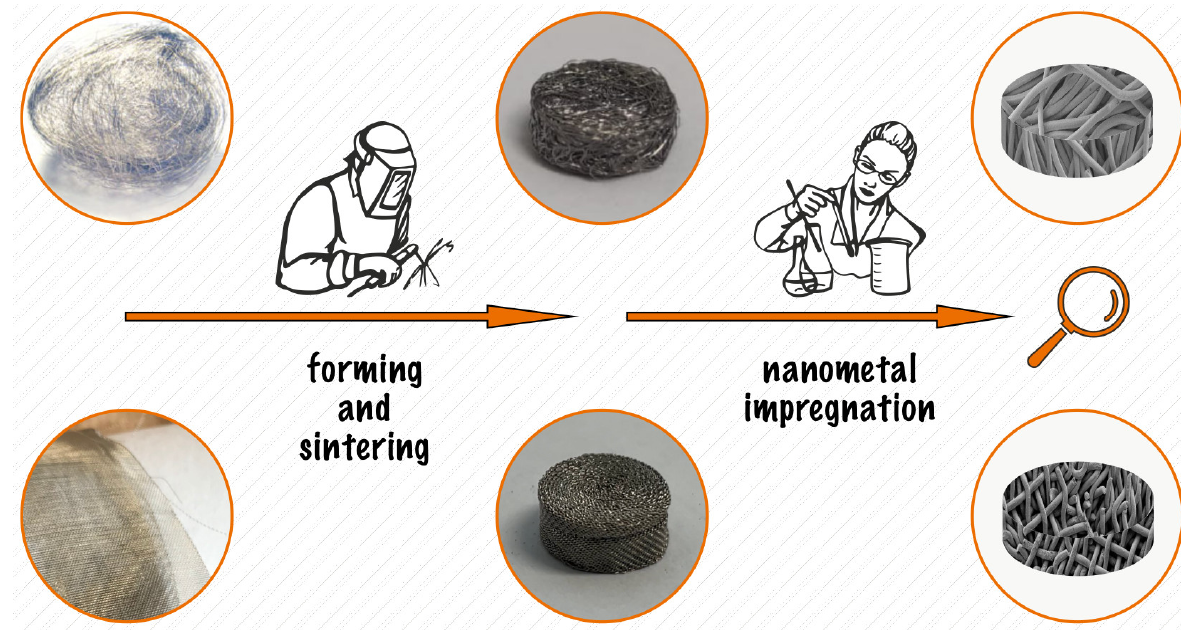
Figure 1. Scheme of the preparation procedure for Ni-wool or Ni-mesh supported catalysts.